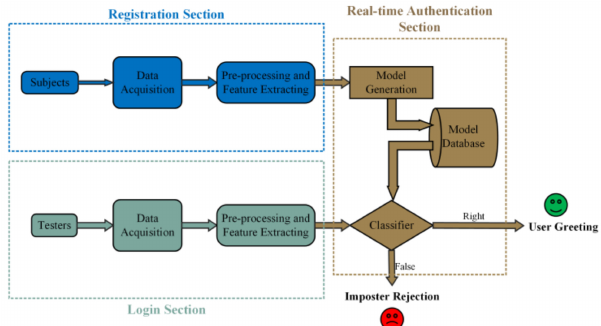
Figure 1. Flowchart of the identity authentication system design.